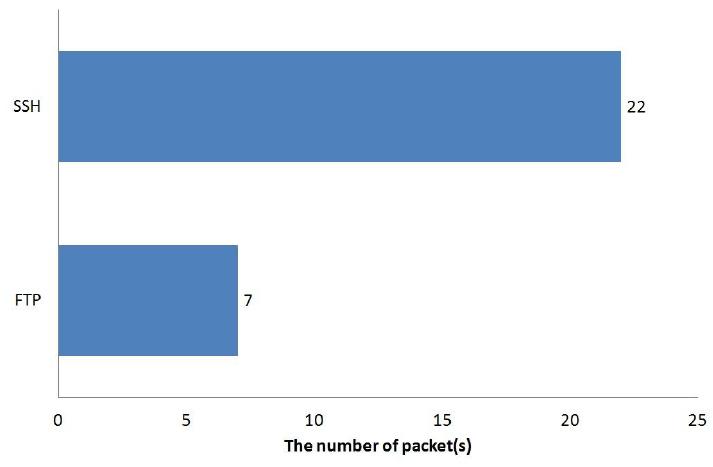
Figure 7. Numbers of packets used in creating the SSH and FTP connections.